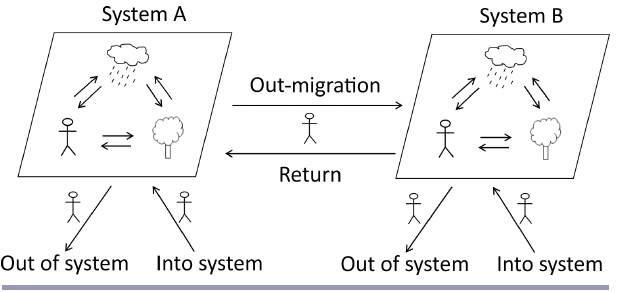
Fig. 1 . Conceptual framework of coupled social-ecological systems connected through migration. Tree and rain cloud represent the natural environment and the stick man represents the human actor; each of the subsystems can represent more than one origin or destination